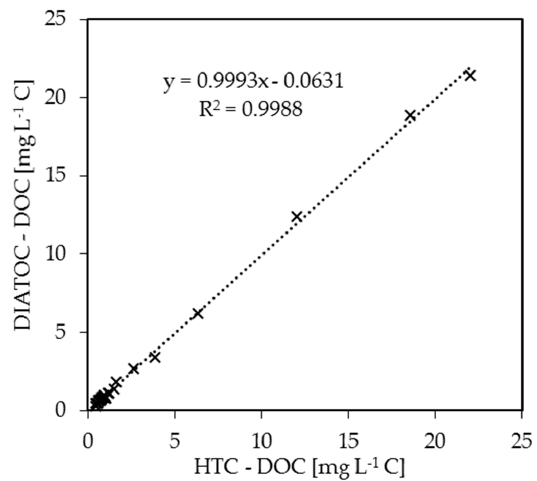
Figure 6. DOC monitoring data and a comparison between prototype (DIATOC) and high-temperature combustion (HTC).